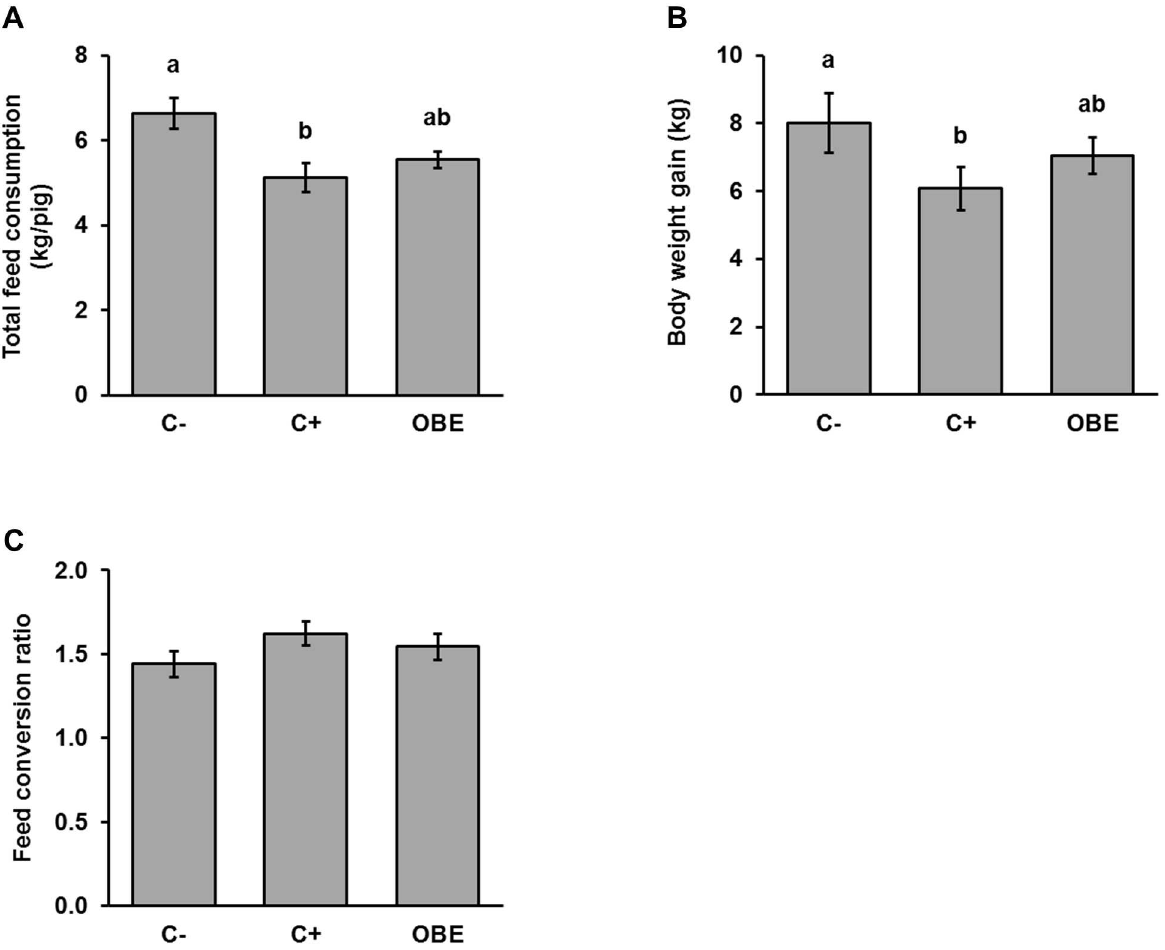
Fig 1. Accumulated feed consumption (kg/pig) and body weight gain (kg) of pigs challenged chronically with LPS and fed an Olive-oil Bioactive Extract (OBE). (A) Feed consumption (kg/pig) of pigs chronically challenged with LPS and fed a commercialpre- starter diet untreated(C-, C+) or supplemented with an olive-oil extract (OBE; 500 mg/kg diet). On d 20, 23, 26 and 29, OBE and positive control (C+) pigs received E . coli -derived LPS injectionsat increasingdoses (60, 66, 72 and 78 μ g/kg). Negative control animals(C-) were injected with saline.(B) Body weight gain (kg) and (C) efficiency of feed conversion(kg of feed consumed/kg of BW gain duringthe experiment) of the pigs treated as describedin A. Bars are least squares means ± SEM (n = 10–11). Different letters indicate significant differences amonggroups ( p <